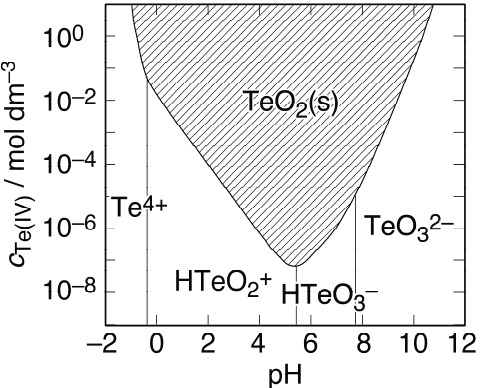
Figure 1. Solubility diagram of tetravalent tellurium species at 298